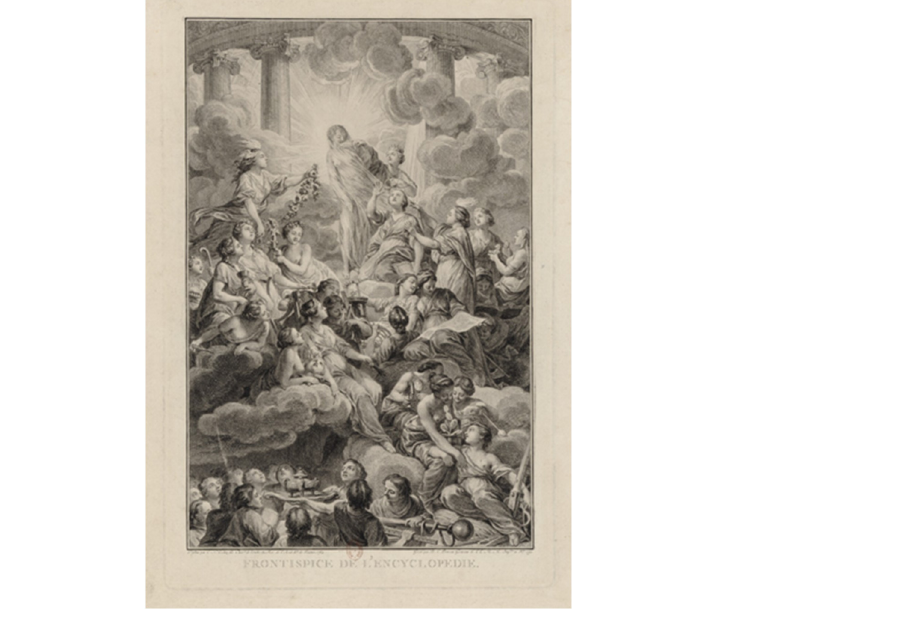
Figure 12. Benoît Louis Prévost (France, 1735?–1804?), after Charles-Nicolas Cochin fils (France, 1715–1790), Frontispice de l’Encyclopédie ou Dictionnaire Raisonné des Sciences, des Arts et des Métiers , 1772 (originaly 1765), Engraving, 33.7 cm × 21.9 cm, Bibliothèque Nationale de France, Paris; Recueil Collection Michel Hennin.